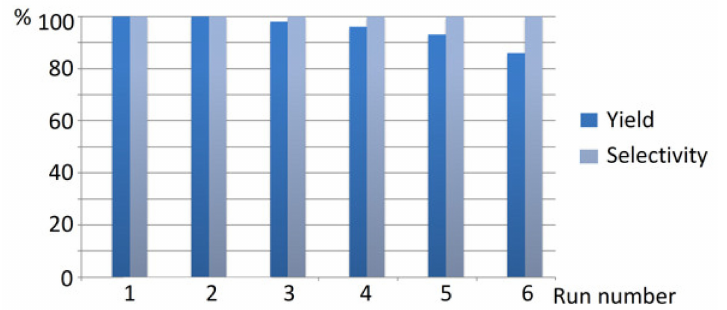
Figure 11. The results of Ni/C-3 catalyst recycling in the hydrogenation of quinoline (2 mol % catalyst loading counting per Ni, p(H 2 ) = 100 atm, T = 100 ◦ C, MeOH, 24